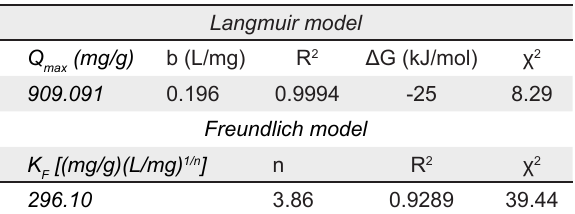
Table 1. Parameters of Langmuir and Freundlich constants of Iodine adsorption.